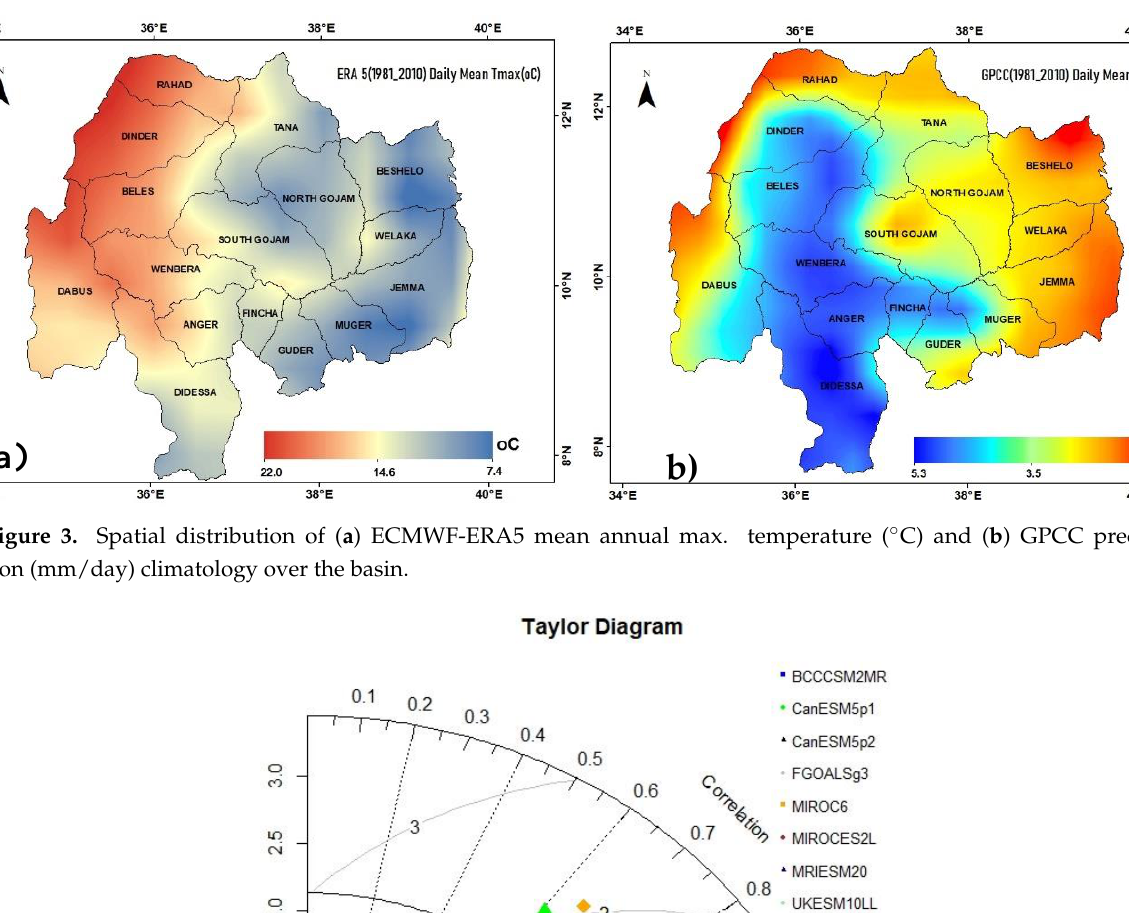
tion (mm/day) climatology over the basin. (mm/day) climatology over the basin.